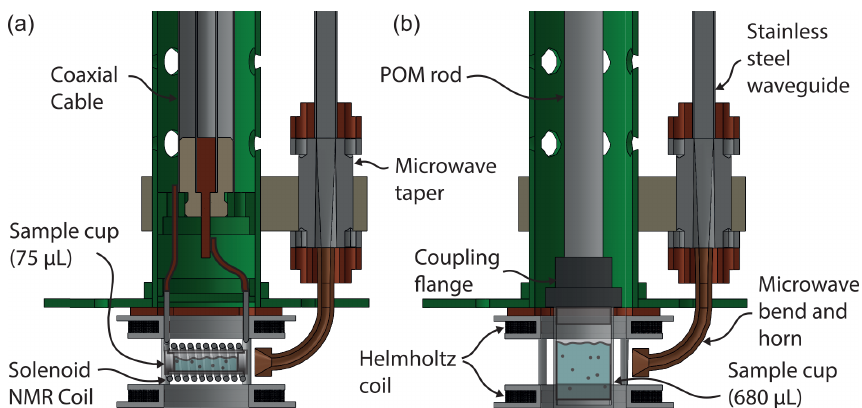
Figure 1. Slice through the bottom of the 7T DNP probe in DNP-NMR configuration (a) and EPR configuration (b) . The split Helmholtz coil is wound inside of two U-profiled polychlorotrifluoroethylene discs. These accommodate enough space to insert the NMR coil as well as a 680µL sample cup.